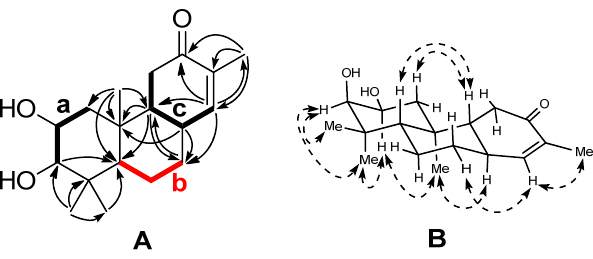
Figure 2. ( A ) Selected 1 H- 1 H COSY ( ▬ ) and HMBC ( → ) correlations of 1 ; ( B ) Selected NOESY correlations of 1 (